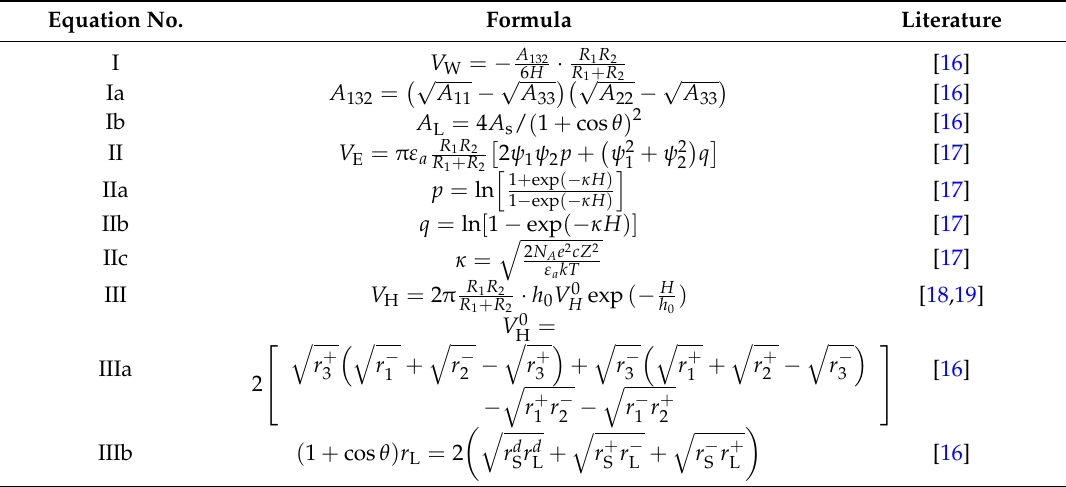
Table 1. XDLVO theoretical calculation